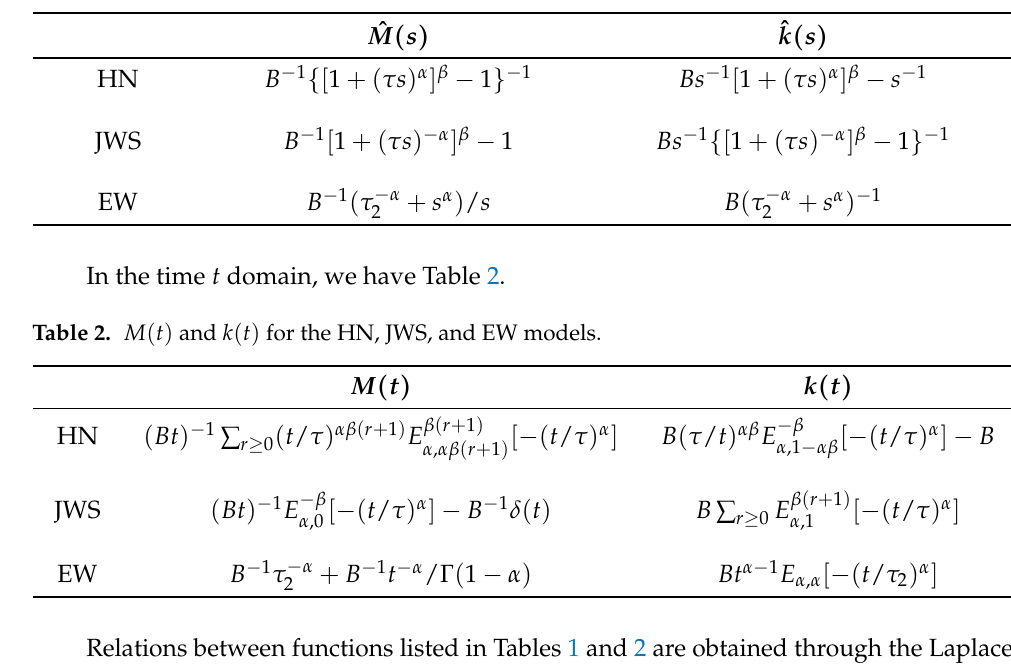
Table 1. ˆ M ( s ) and ˆ k ( s ) for the HN, JWS, and EW models.